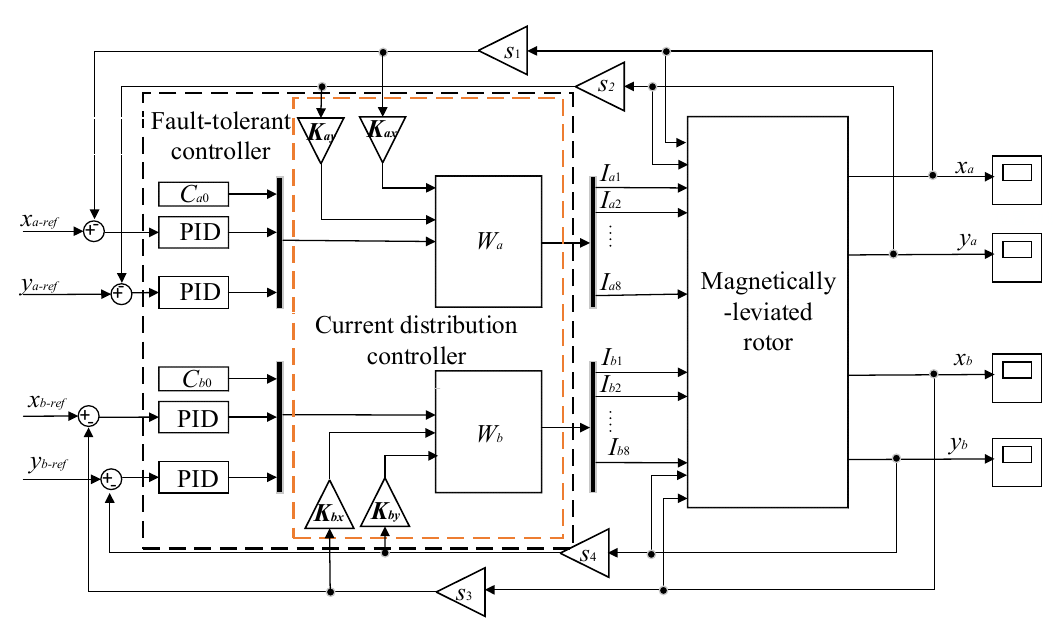
Figure 10. Control block diagram of the entire system.